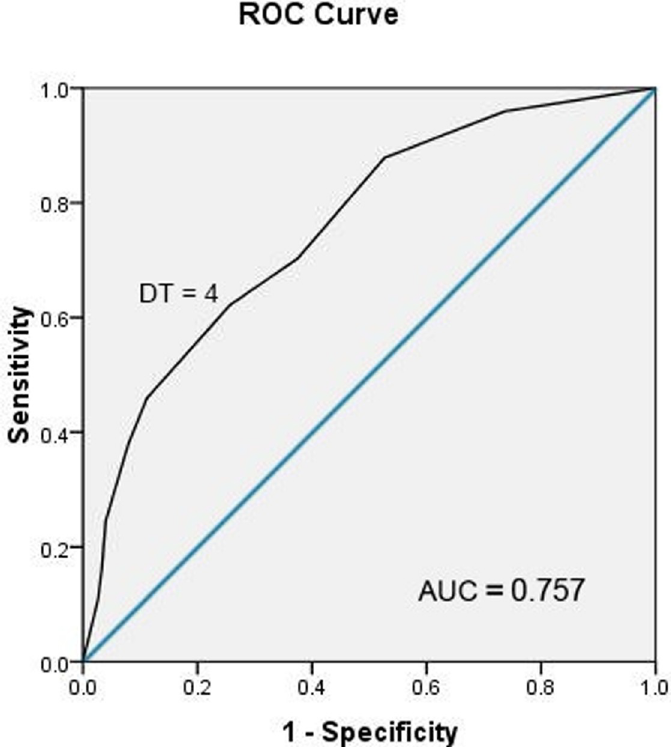
Fig 1. Receiving operating characteristics (ROC) curve of the Distress Thermometer (DT) score versus Hospital Anxiety and Depression Scale cutoff scores of 247 cancer patients.